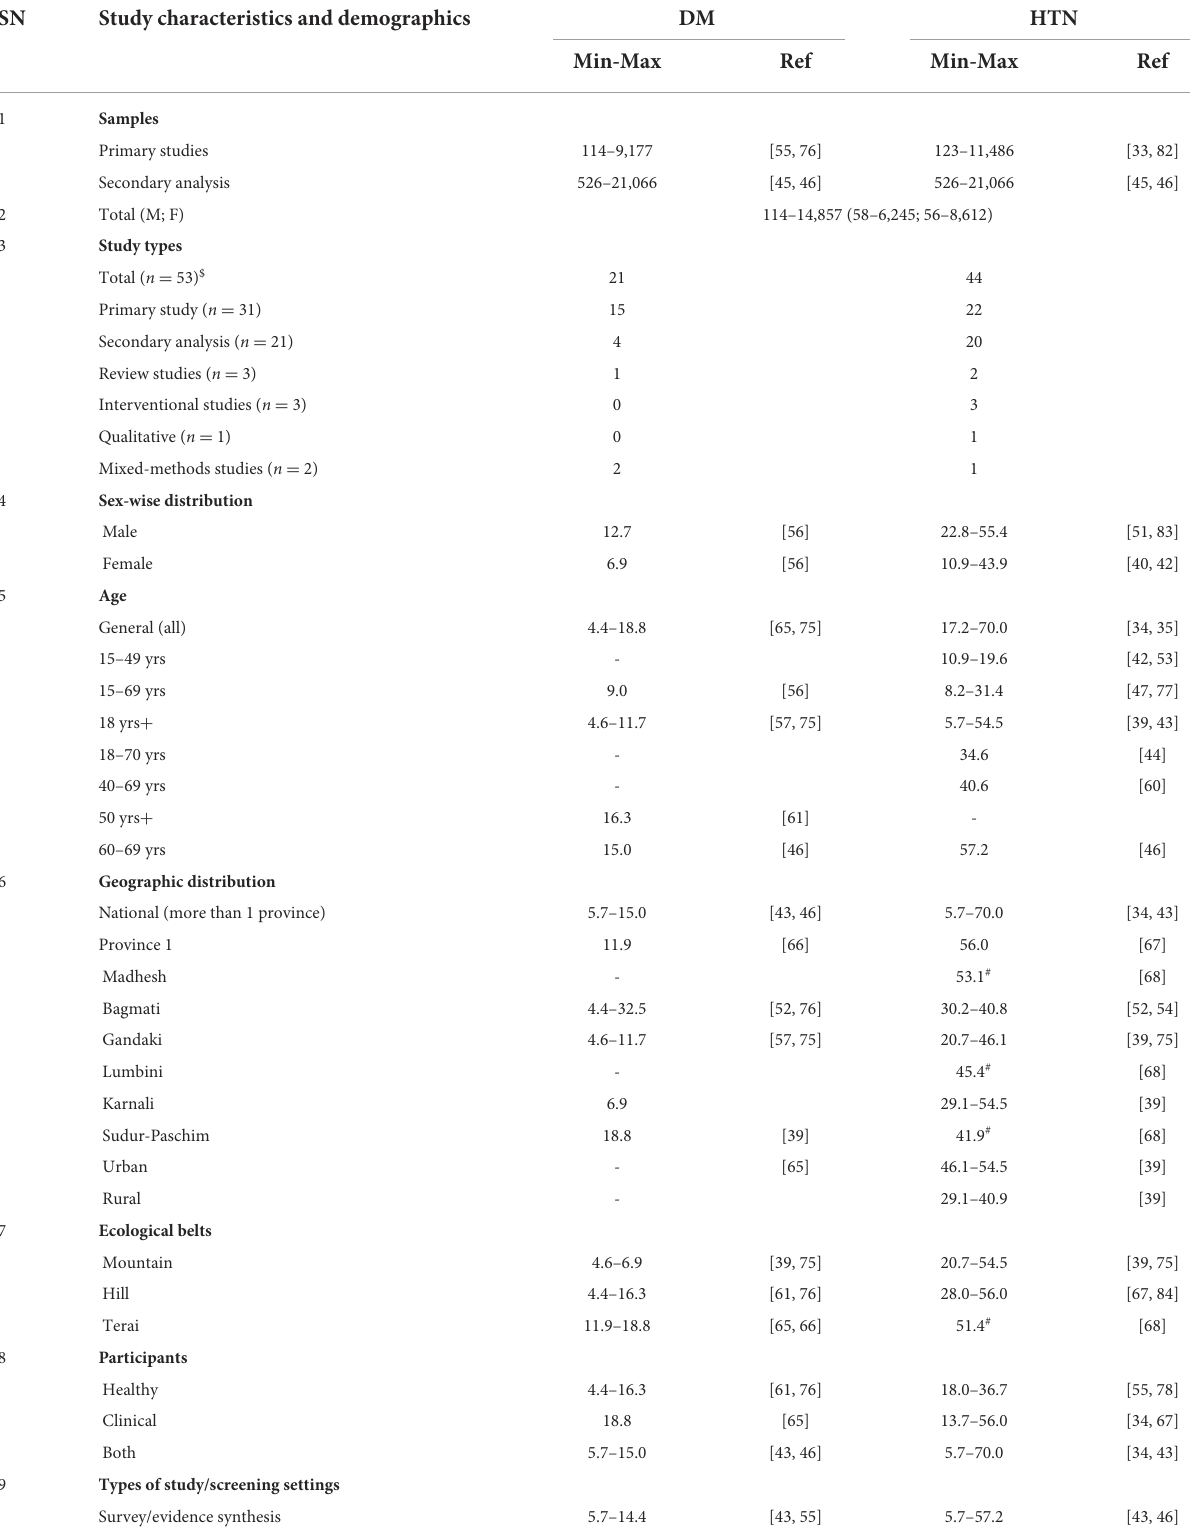
TABLE 4 Disease-wise summary prevalence/proportion (range * ) of included